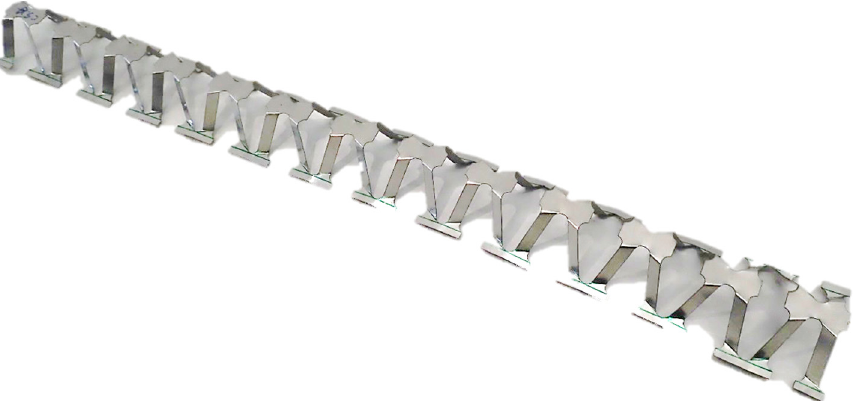
Figure 3. A strip of mechanically expanded perforated corrugated structure—pyramidal cellular structure.